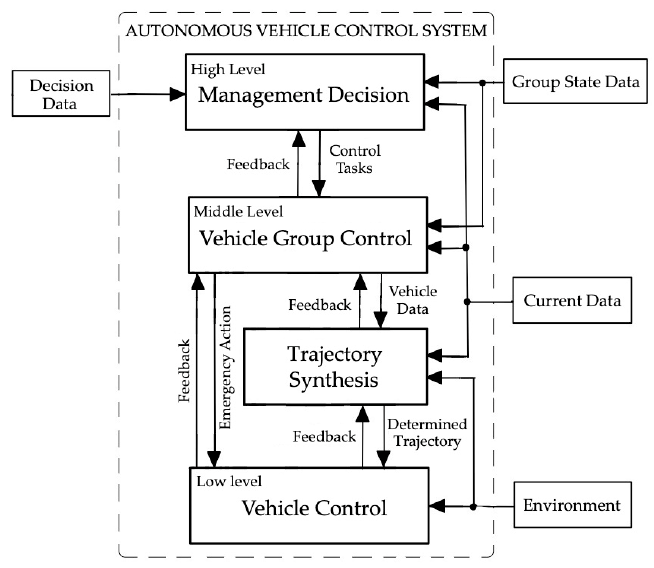
Figure 1. The structure of a group of autonomous vehicles in a hierarchical control system.